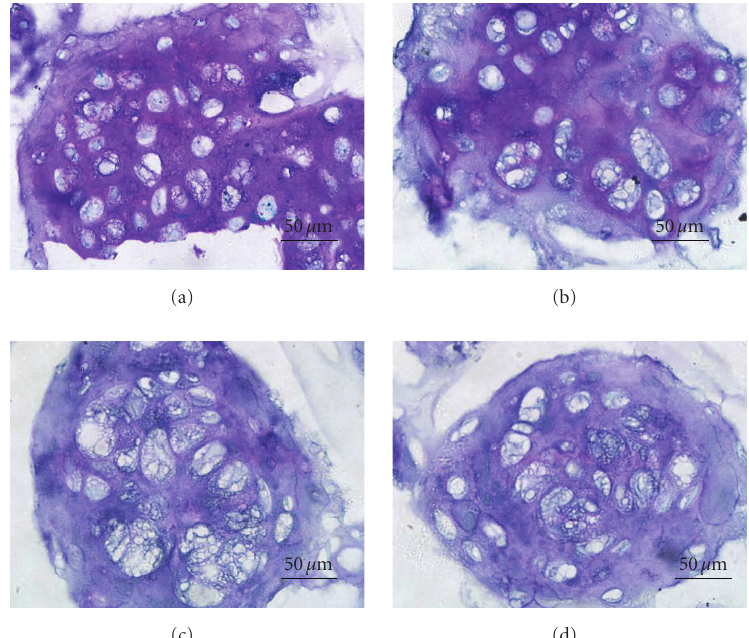
Figure 2: Toluidine blue staining for chondrocyte-seeded alginate hydrogels maintained in (a) medium supplemented with 1% ITS plus 2% FBS, (b) medium with 1% ITS plus 4% FBS, (c) medium with 1% ITS plus 8% FBS, or (d) medium with 10% FBS for 21 days. The scale bars indicate 50 μ